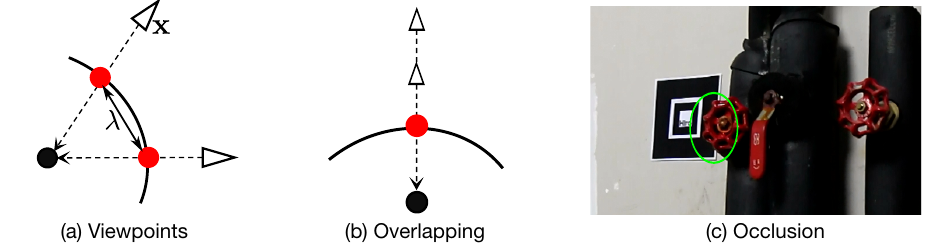
Figure 6. Viewpoint calculation and density